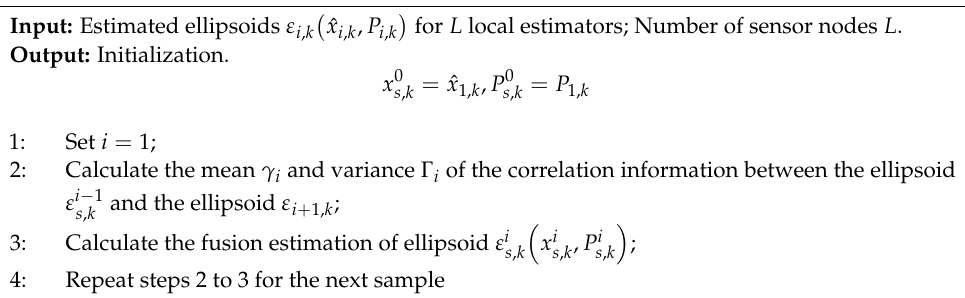
Algorithm 1. DSEI Fusion